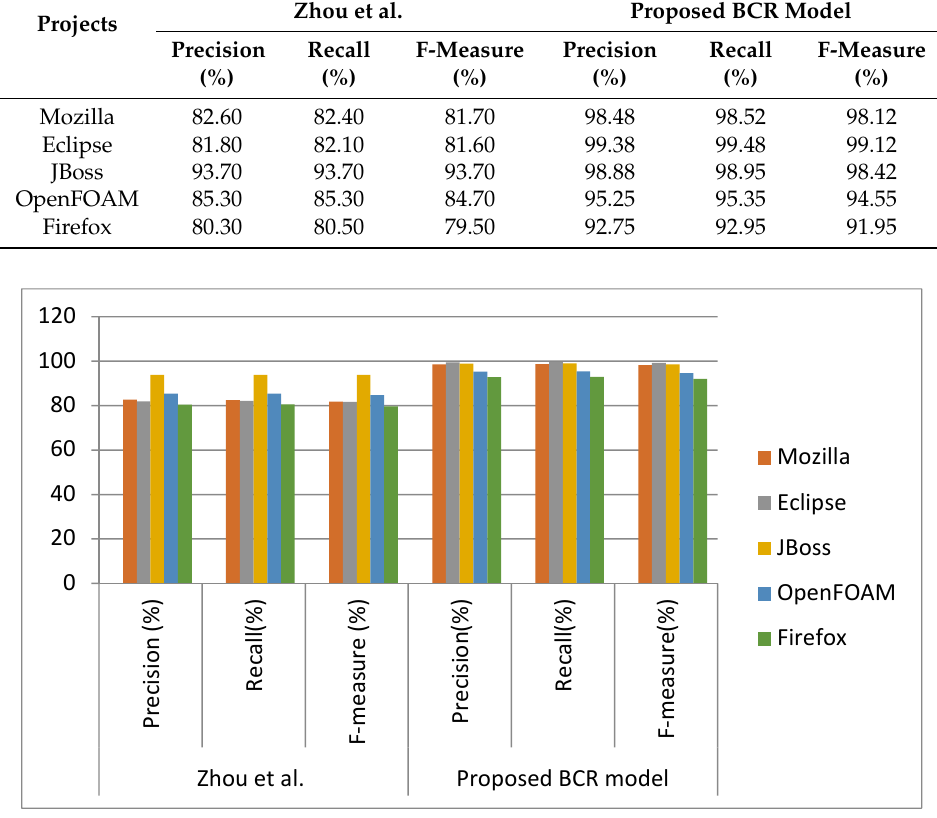
Figure 11. Comparison of the proposed and existing bug severity classifier on binary classes .